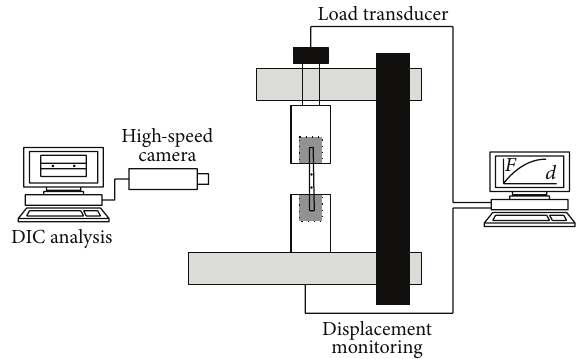
Figure 2: Schematic of the tensile test. The test specimen (feather shaft) was center-mounted onto the wedge clamps. Tensile force ( 𝐹 ) was measured while the specimen was pulled at a constant rate of 0.5 mm/min. Tensile process was recorded by a high speed camera and the strain of the specimen was calculated from DIC analysis of the CCD images. DIC analysis was applied with the purpose of excluding the influence caused by the sample debonding, clamping, and the measurement error of sample’s initial length.